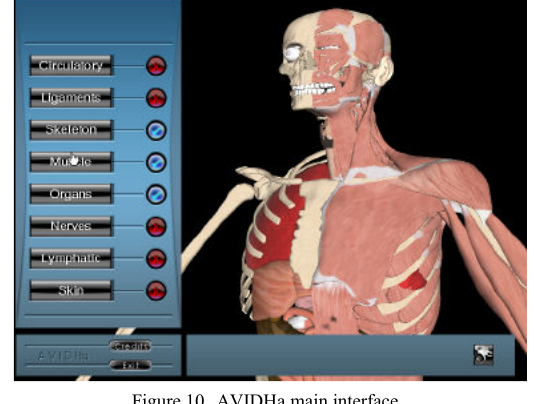
Figure 10. AVIDHa main